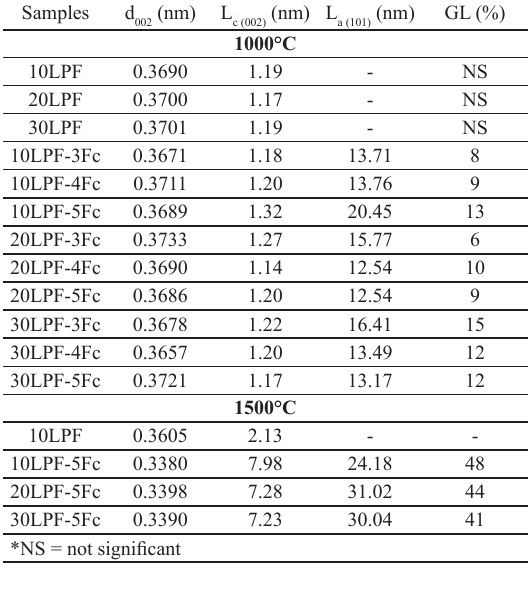
Table 6. Interlayer spacing, and crystallite height values of carbon derived from LPF resins containing ferrocene Samples